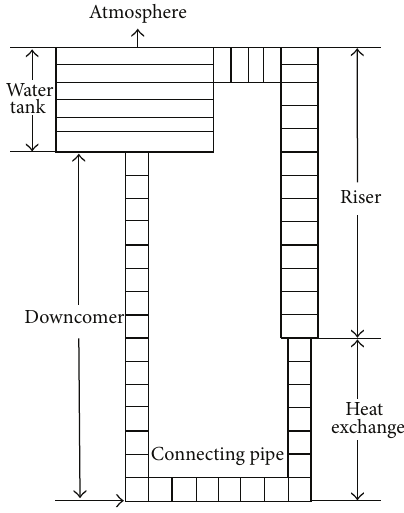
Figure 2: Schematic of the nodalization.